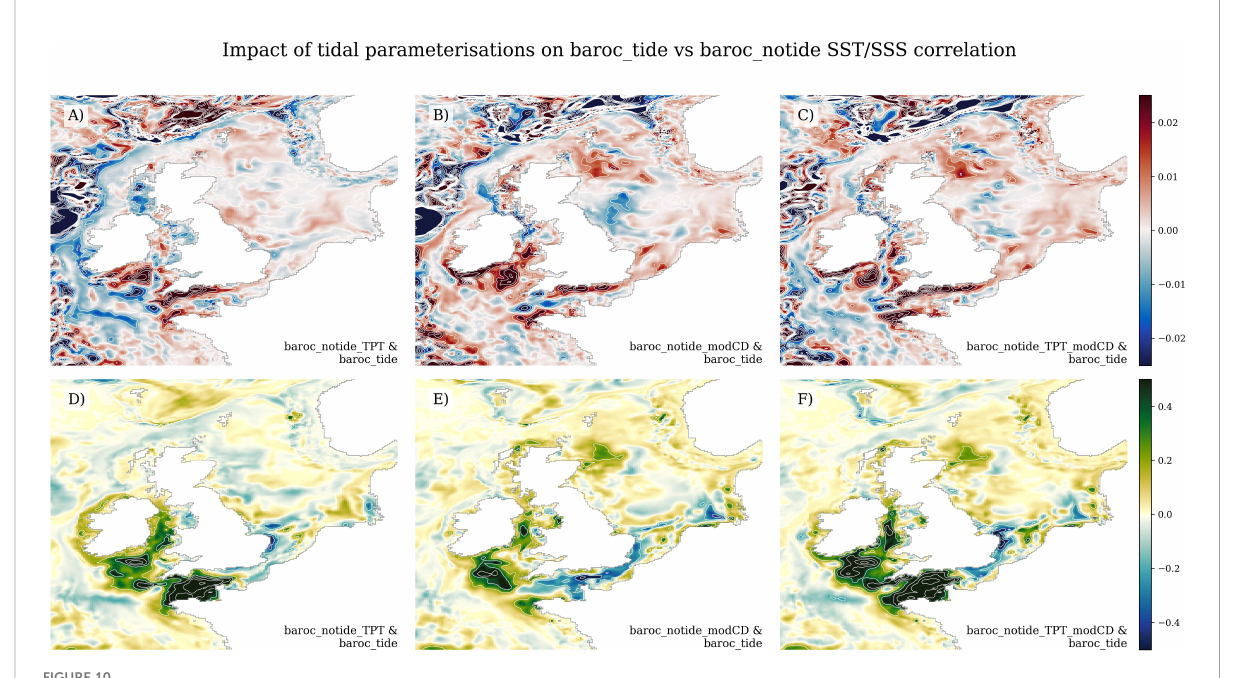
FIGURE 10 Impact of tidal parameterisation on the SST (A – C) and SSS (D – F) predictability. The temporal correlation between the winter SST and SSS (from 3 month for each of the 10 years) between baroc_tide and baroc_notide show how much the tides could affect predictability (Supplementary Material Figure 12). Here we show how that correlation is improved when we apply the tidal parameterisation: (A, D) the TPT parameterisation, (B, E) the modi fi ed bed drag coef fi cient, and (C, F) , both. Positive numbers show an